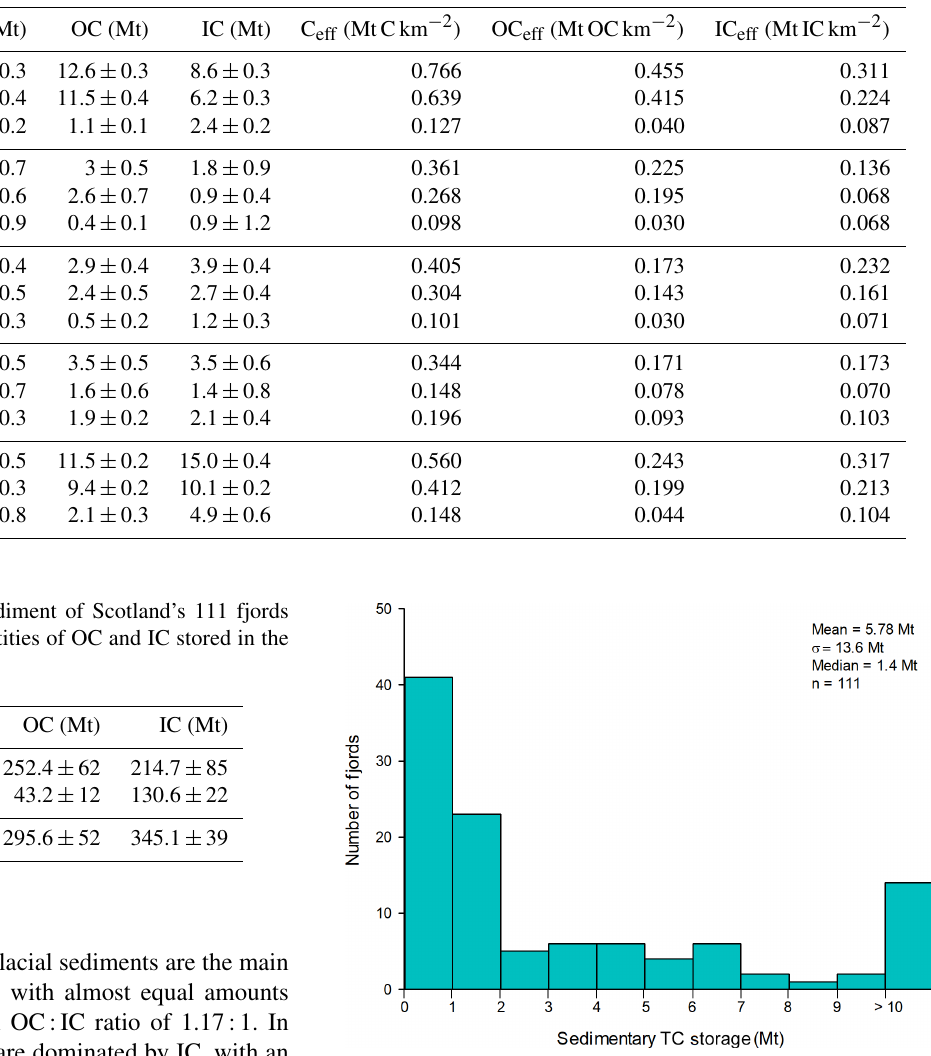
Figure 5. Frequency distribution of sedimentary TC stock estimates for Scotland’s 111